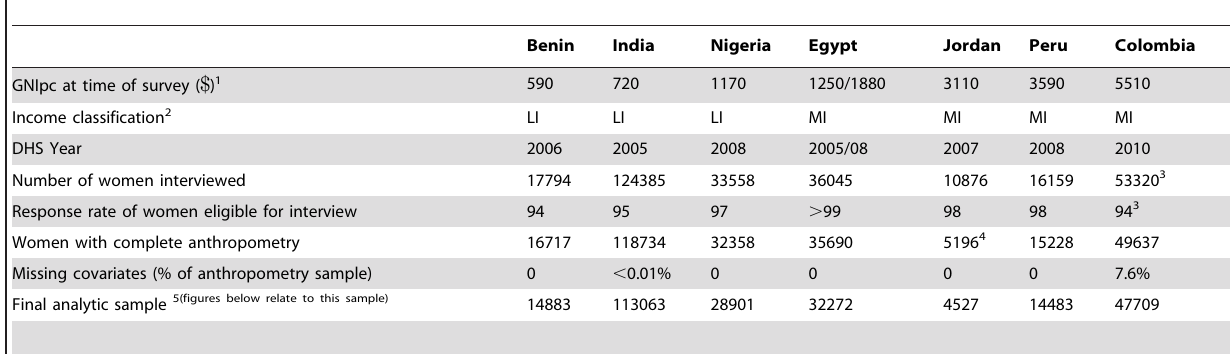
Table 1. Sample details by economic classification at the time of the DHS survey for each country included in the